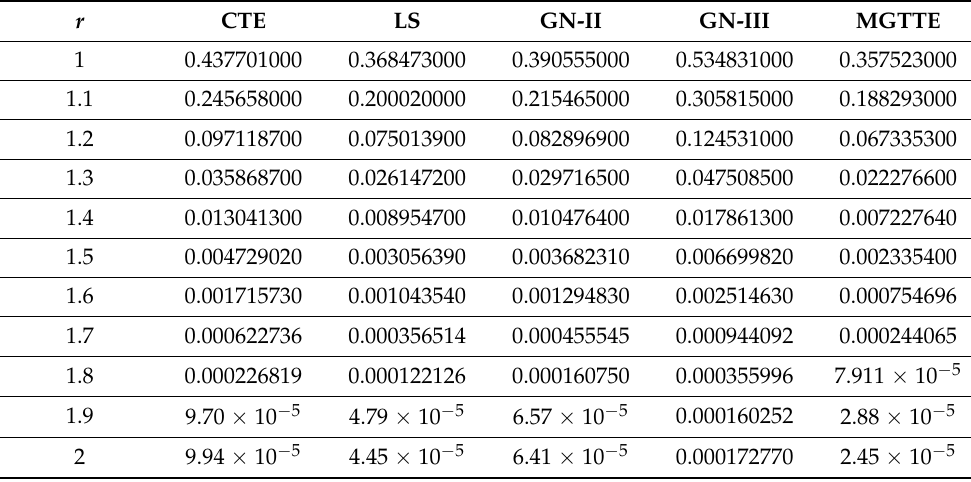
Table 2. The displacement, u , versus different models of